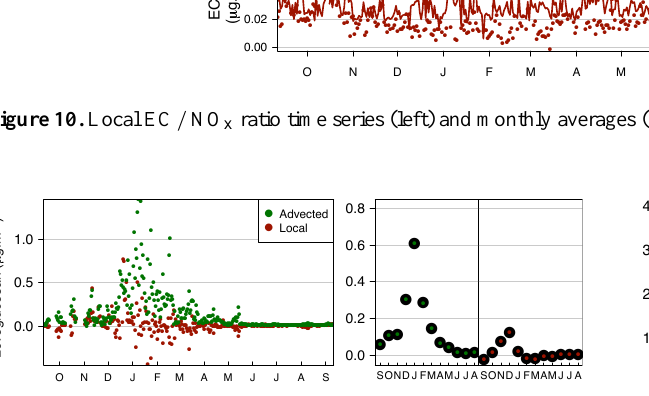
Figure 11. Daily (left panel) and monthly (right panel) advected (green) and local (red) levoglucosan contributions.